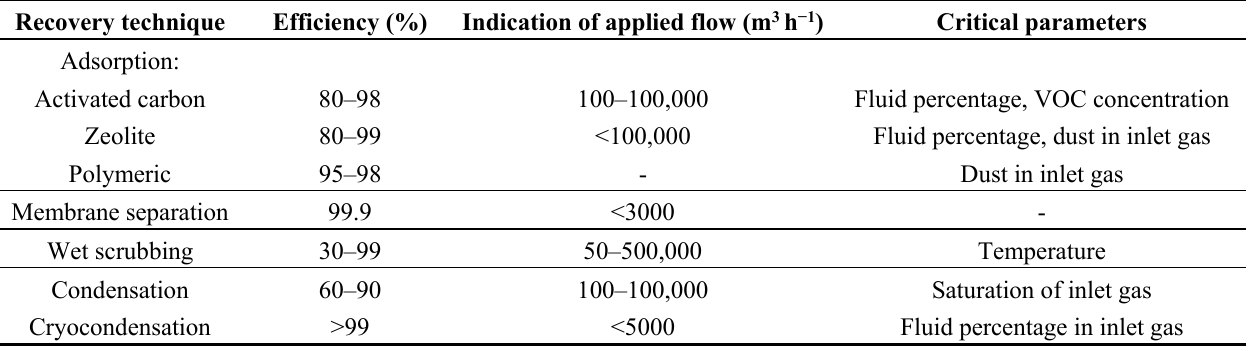
Table 1. Characteristics of the volatile organic compounds (VOC) recovery techniques